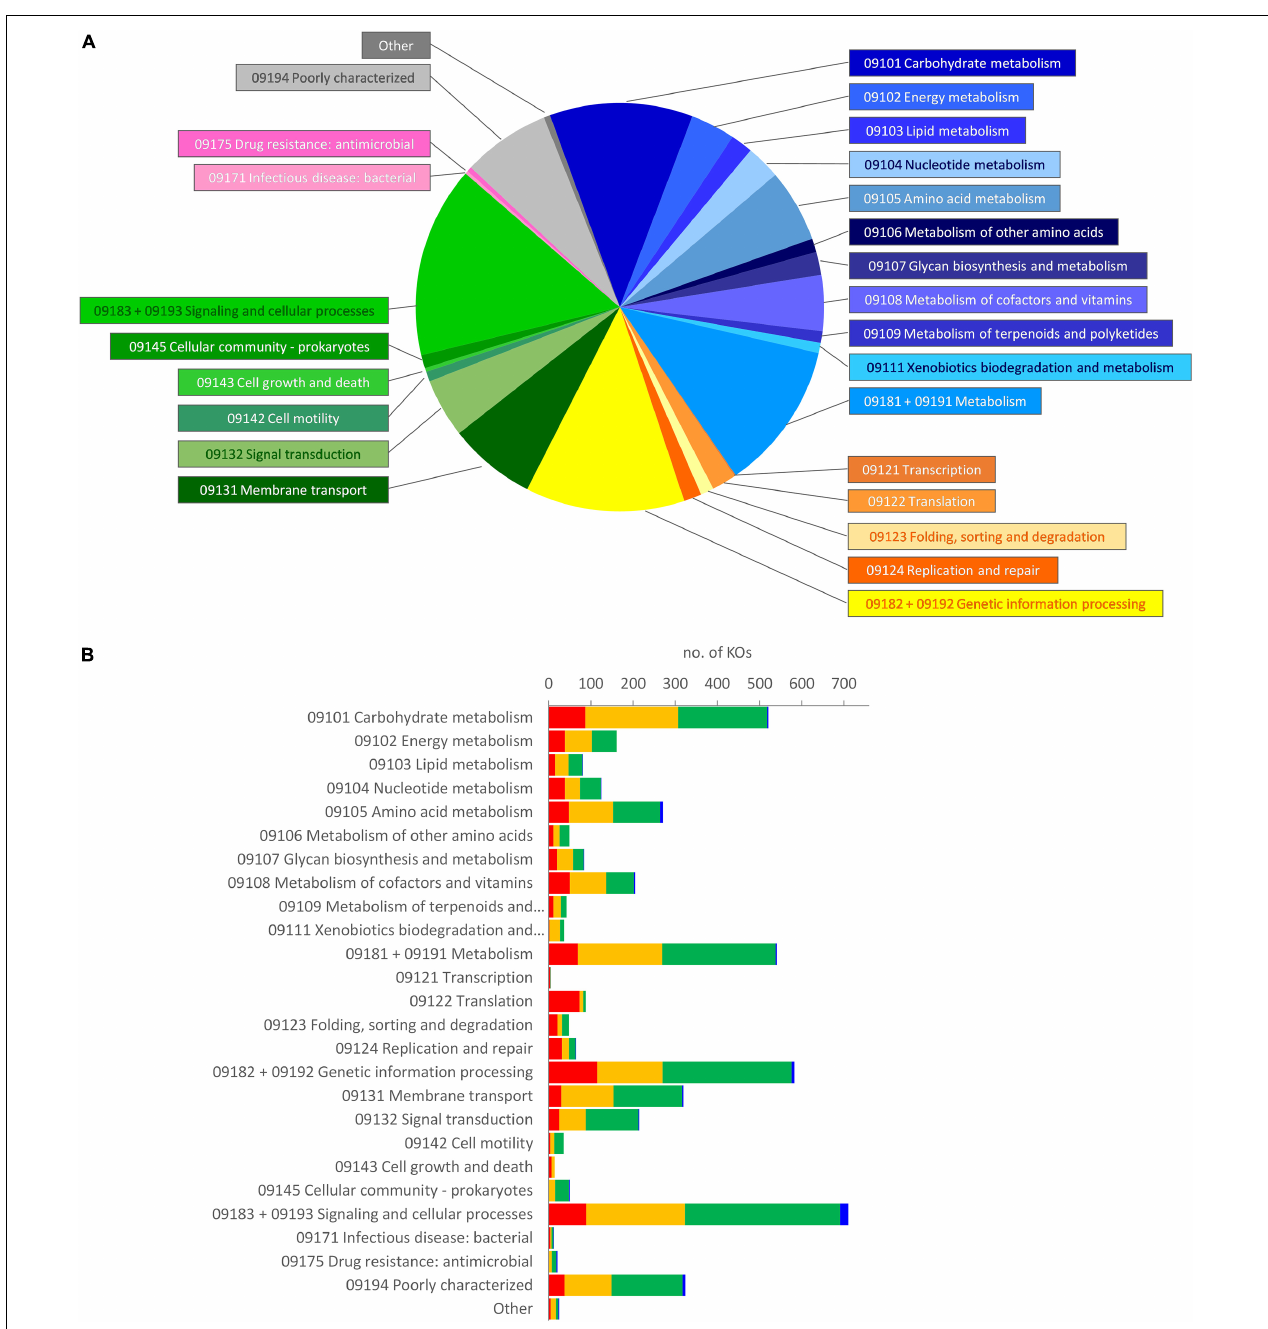
FIGURE 4 | Brite’s hierarchical classification of the functions predicted in the metagenome of microbiota cultures, enriched in a protein-based medium. (A) Classification of the core KOs shared by all the founding microbiota at 0 h. Blue, metabolism; yellow/orange, genetic information processing; green, environmental information processing and cellular processes; pink, human diseases; gray, poorly characterized and other functions. (B) Distribution of the KOs that presented a significant differential abundance in enrichment cultures, according to LEfSe ( p < 0.05). The KOs in the core metagenome that decreased (red), did not significantly change (yellow), or increased (green), and those, absent in the core metagenome that appeared during cultivation (blue), are reported. KO, Kyoto Encyclopedia of Genes and Genomes Orthology.